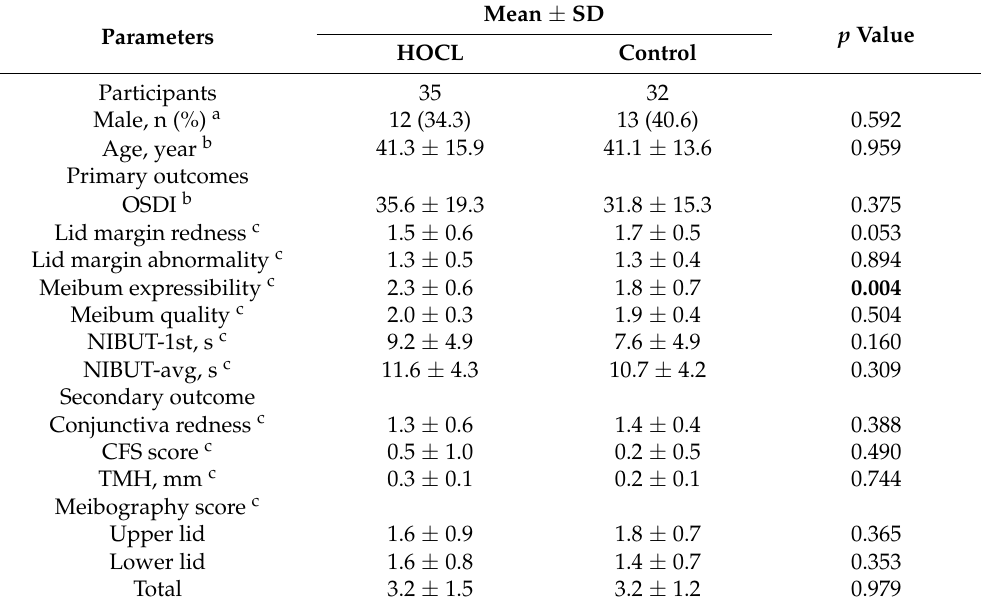
Figure 2. Flow diagram according to the consolidated standards of reporting trials (CONSORT) statement, showing enrollment, randomization, and patient flow in this study of 0.01% hypochlorous acid for blepharitis. Table 1. Demographic characteristics and ocular surface parameters of hypochlorous acid and control groups at baseline.